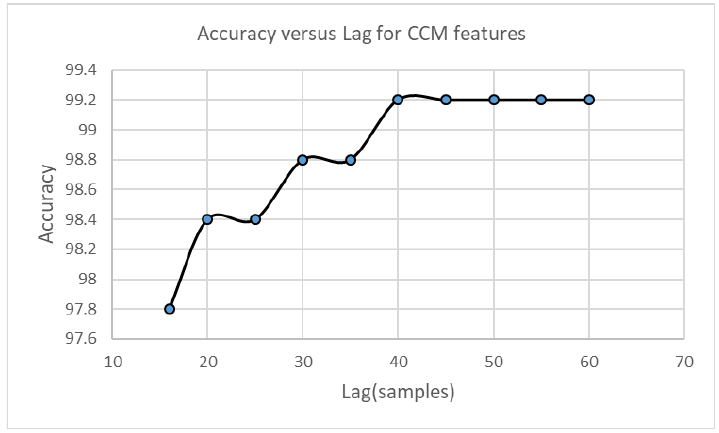
Figure 19. Accuracy according to Lag = τ for CCM